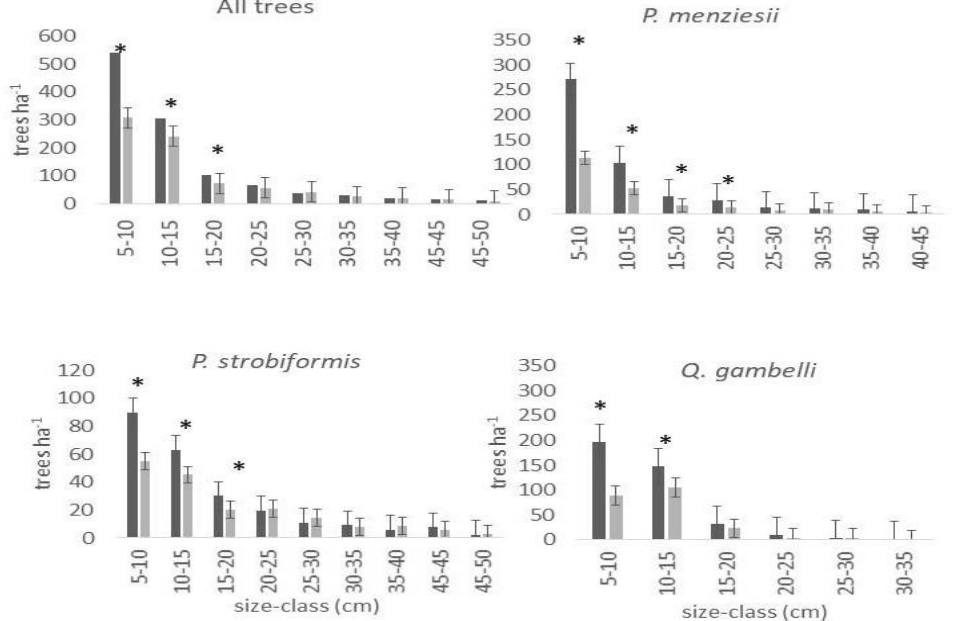
Figure 3. Mean size-class distributions (# ha − 1 ) in 5-cm size classes for all trees (+1 S.E.) and for tree species that displayed significant changes in forest size structure in response to the Coyote Fire. Asterisks signify significant paired t -tests between the pre- and post-fire sampling interval at p < 0.05 for trees > 5-cm DBH at Guadalupe Mountains National Park.